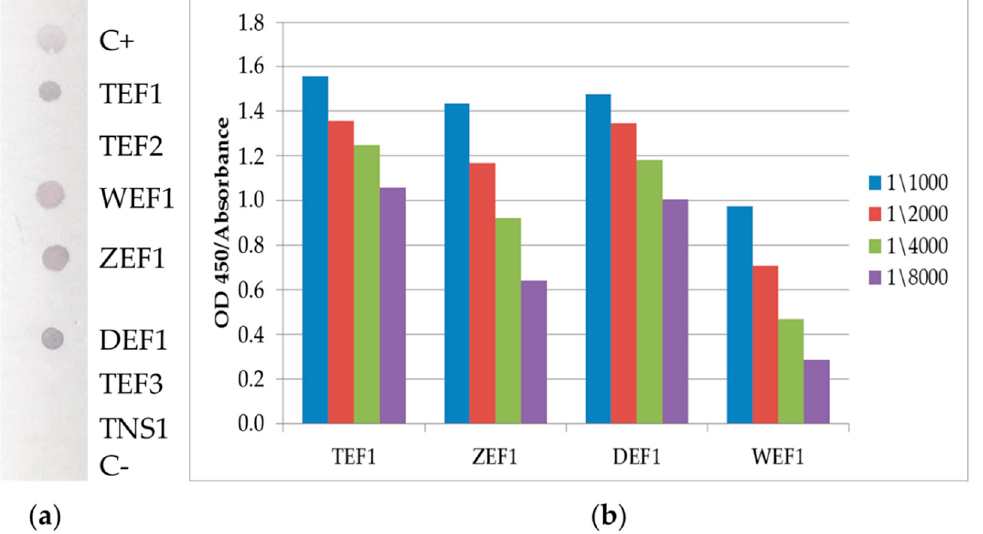
Figure 2. The interaction of the antibody with fragments of viral proteins. ( a ) Dot blot analysis: The membrane was blotted with C+—mouse antibody (positive control); Fragments polyproteins TEF1, TEF2, WEF1, ZEF1, DEF1, TEF3, TNS1 (as shown), C − —RBD SARS-CoV-2 (negative control). After that, the membrane was incubated with 10H10 mAb. Binding of 10H10 to immobilized proteins was detected with secondary anti-mouse antibody conjugated with AP. ( b ) ELISA: TEF1, WEF1, DEF1 and ZEF1 proteins were immobilized on 96-well plates. 10H10 mAb were added to wells. Binding of 10H10 to immobilized protein was detected with secondary anti-mouse antibody conjugated with HRP.